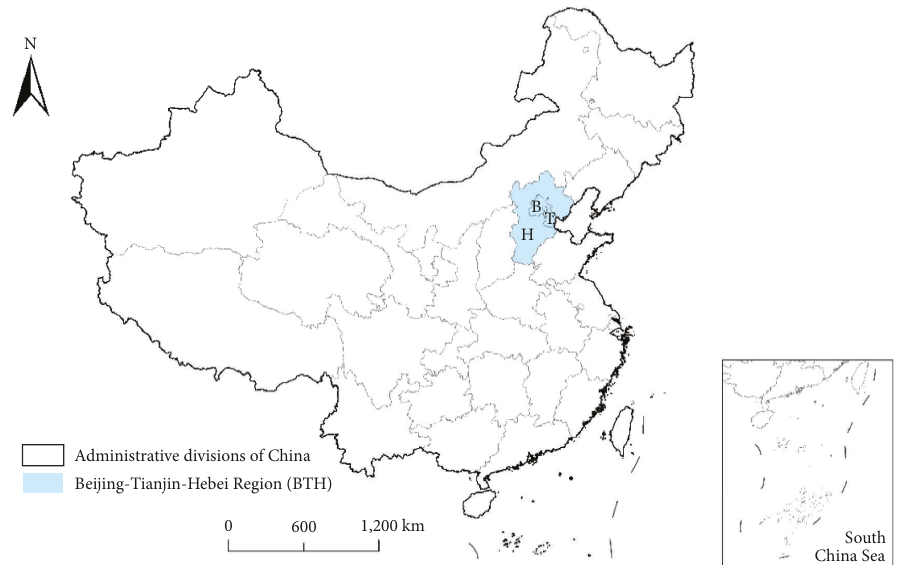
Figure 1: Geographical location of the BTH region in China.